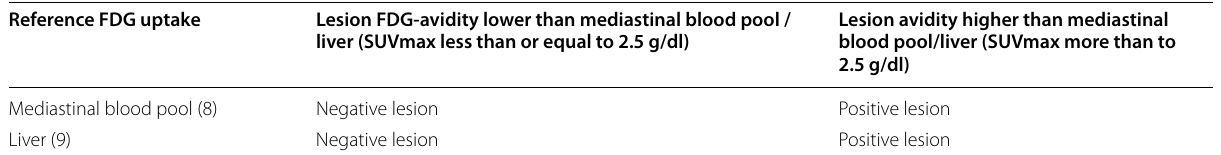
Table.1 Qualitative assessment of the lesions on 18 F FDG PET-CT Reference FDG uptake